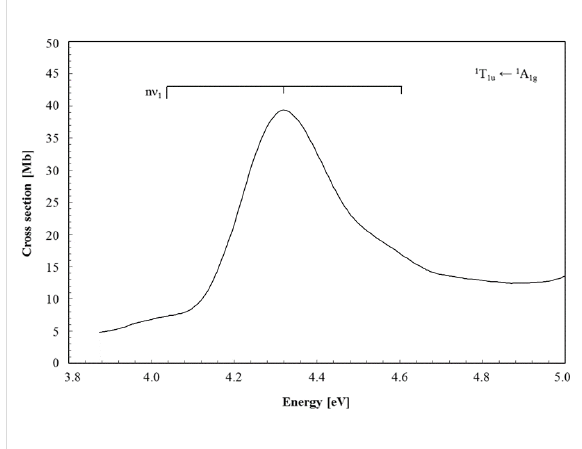
Figure 3: High-resolution VUV photoabsorption spectrum of W(CO) 6 in the photon energy range of 3.9–5.0 eV. See text for details on the as-